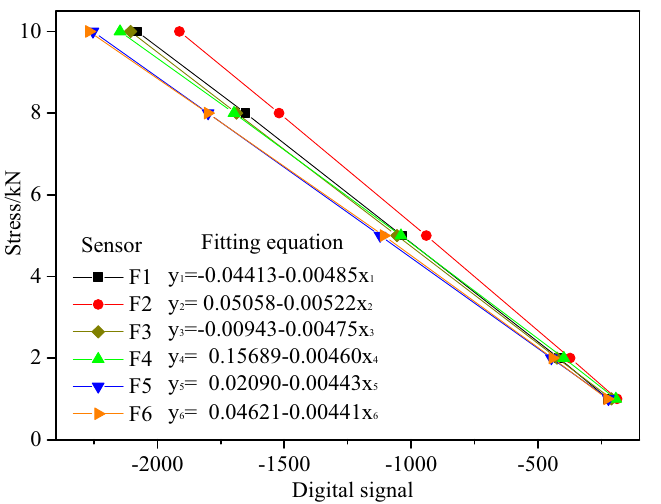
Figure 8. Data linear fitting and regression equation.